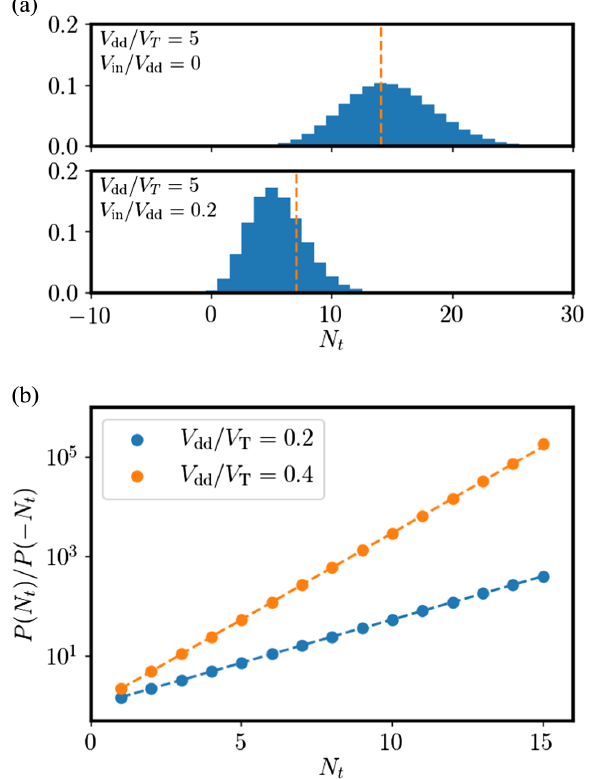
FIG. 12. (a) Probability distributions for the number of charges N that go through the pMOS transistor during a time t ¼ 10 − 1 t 0 t 0 . 1 ). =q in the stationary state, for different input voltages ( q e T ¼ Dashed lines indicate the values obtained from a deterministic =P ð − N analysis. (b) P ð N ratio as a function of N for two t Þ t Þ t 0 . 01 ). The dots correspond to =q different power voltages ( q e T ¼ the numerical results obtained with the method of full counting statistics, and the dashed lines to the expected result according to the DFT in Eq.